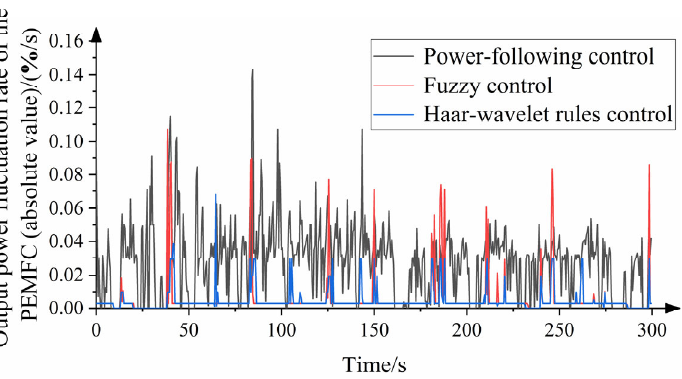
Figure 20. Comparison of the output power fluctuation rate of the PEMFC with different control strategies.